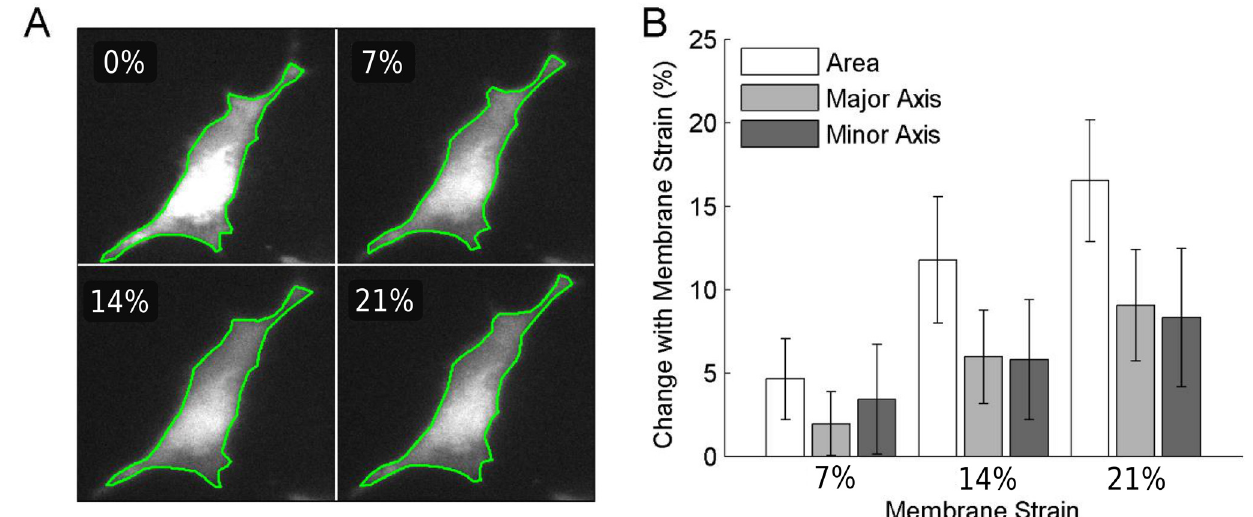
Fig 4. An example of a cell tracked and imaged in increments of 7% area strain (A). The outline of the cell was manually selected and the cell shape was fitted with an ellipse whose major and minor axes were measured (B). The area strain of cells was measured (n = 8) and compared to the prescribed membrane area strain. The measured cell area strain is lower than the prescribed strain, but is within one standard deviation at each measured increment. The major and minor axes of the cell increase equally, demonstrating biaxial strain.